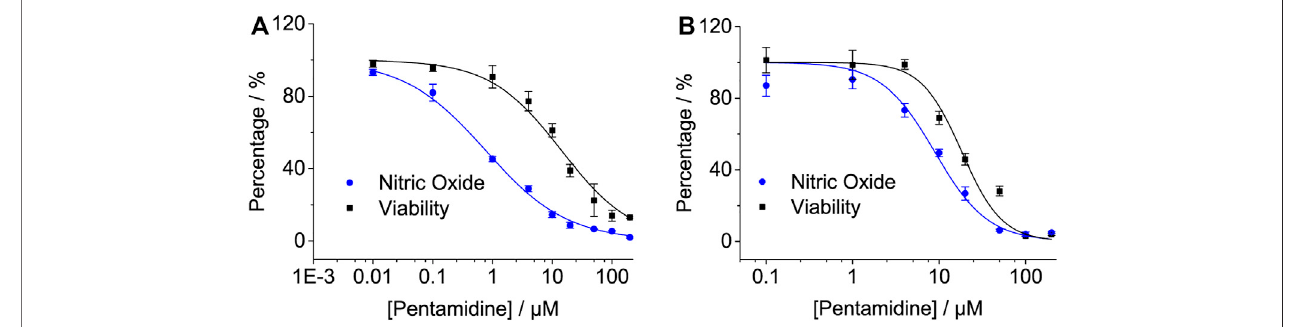
FIGURE 5 | Pentamidine inhibits LPS-induced pro-in fl ammatory factor NO overproduction in macrophage primary microglia (A) and primary astrocyte (B) . Cells were treated with LPS and indicated concentrations of pentamidine. After 24 h of incubation, NO in the culture supernatant was measured. The NO production of the LPS treated group without pentamidine was set as 100%. The cellular viability of pentamidine was also measured by crystal violet staining. All experiments were performed 3 – 4 times independently, and data are given as the mean ± S.E.M.